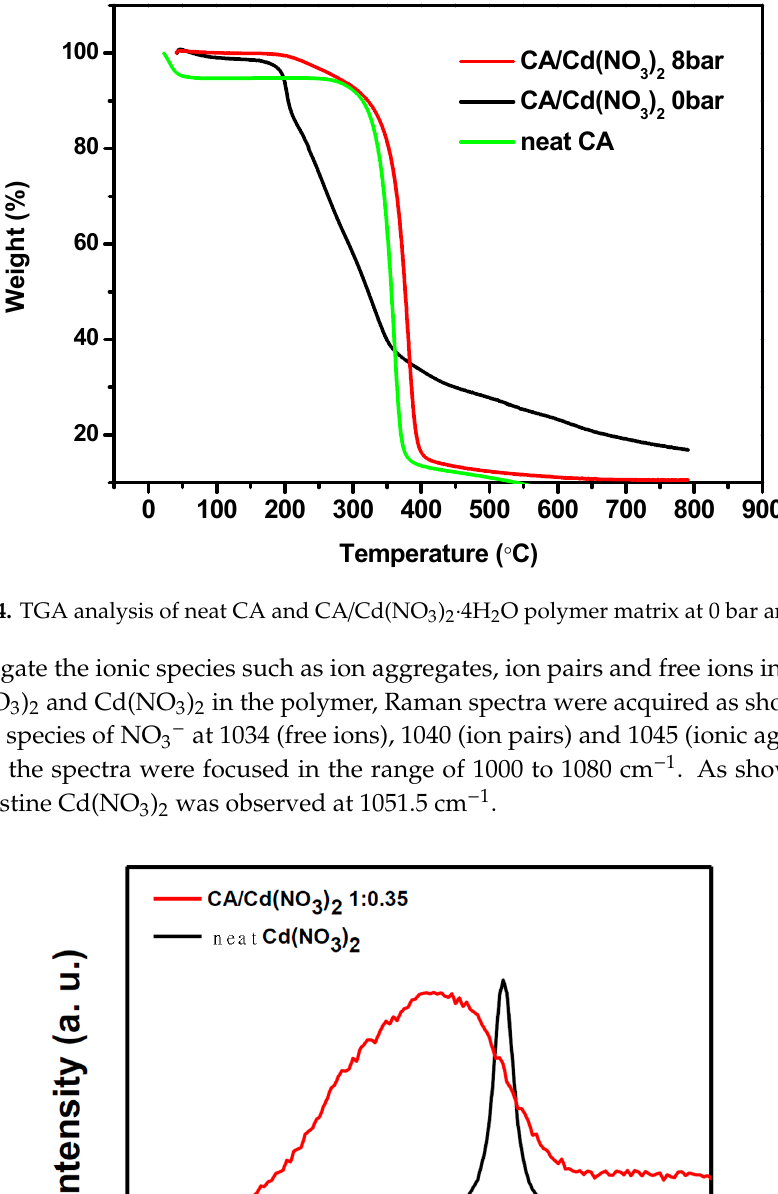
/ Cd(NO · 4H · 4H 3 ) 2 2 O and CA 3 ) 2 2 O polymer